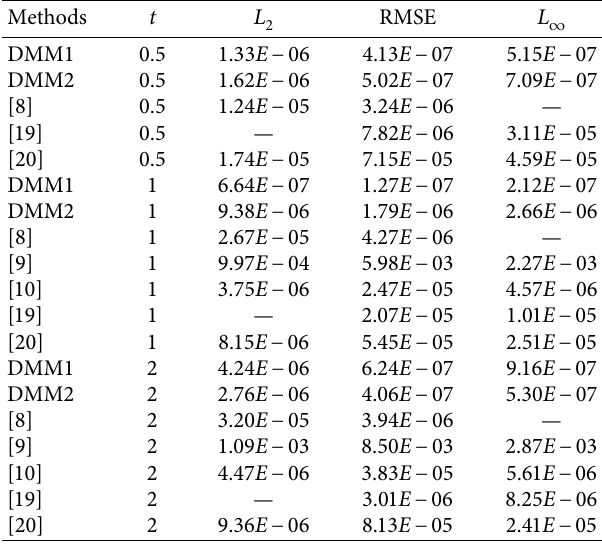
Table 1: Numerical results for Example 1.